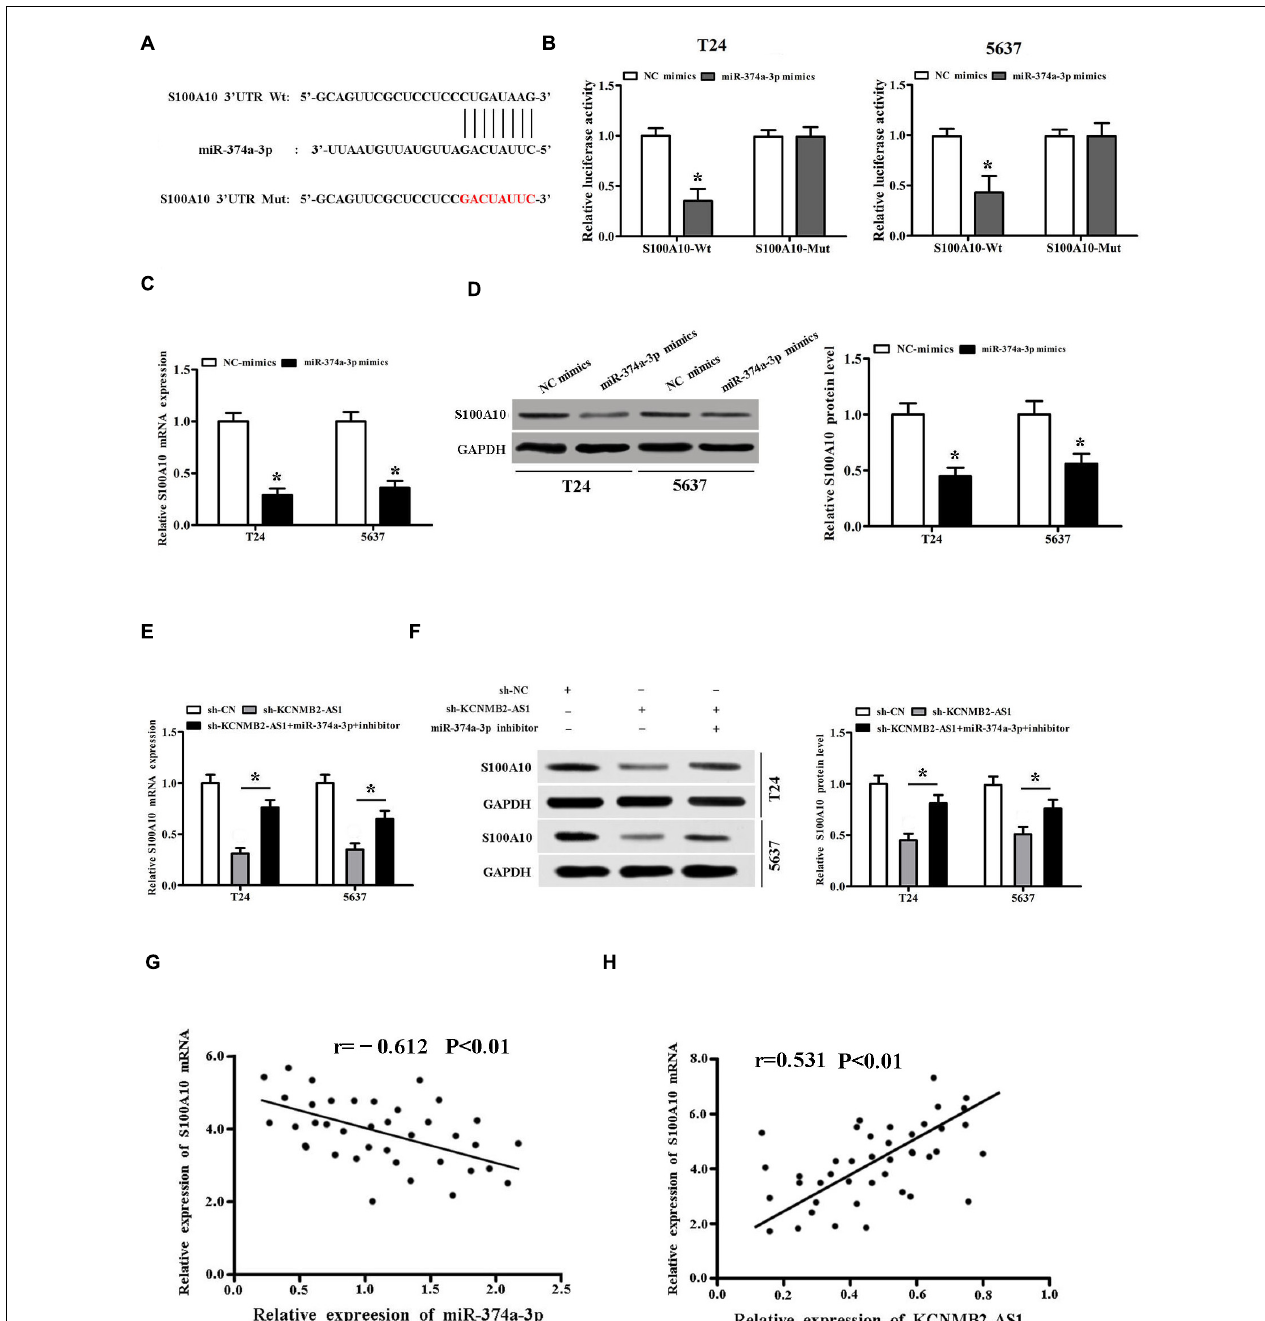
FIGURE 4 | miR-374a-3p targeted S100A10 in BC. (A) TargetScan predicted that S100A10 had a binding site for miR-374a-3p. (B) Dual luciferase report assay validated the interactions among miR-374a-3p and S100A10 in BC cells. (C,D) S100A10 expression was inhibited by miR-374a-3p mimics. (E,F) miR-374a-3p inhibitor reversed the expression of S100A10 inhibited by sh-KCNMB2-AS1. (G,H) Pearson’s correlation analysis was conducted to evaluate the correlation of S100A10 and miR-374a-3p or KCNMB2-AS1 in BC tissues. Data were showed as mean ± standard deviation. The experiment was repeated 3 times. * P <